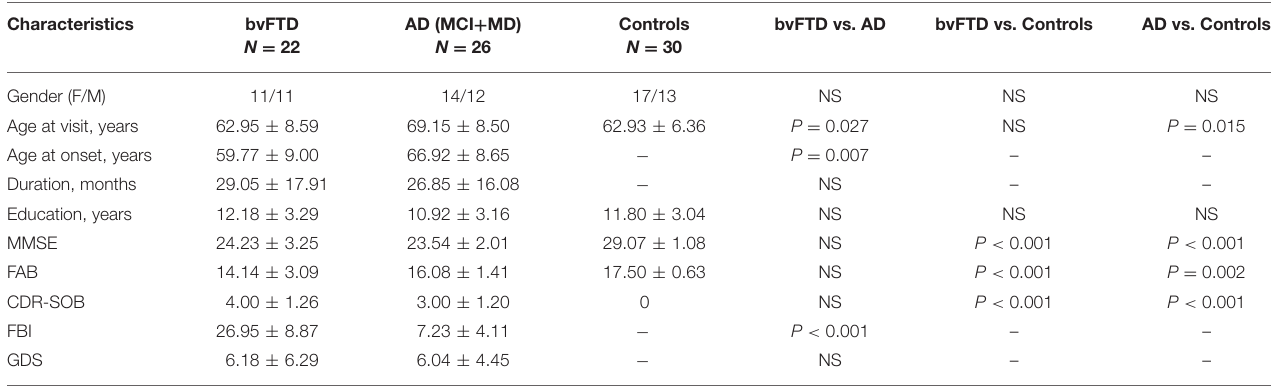
TABLE 1 | Demographic characteristics and general neuropsychological test data for the bvFTD, AD and control groups. Characteristics bvFTD vs. Controls AD vs. Controls